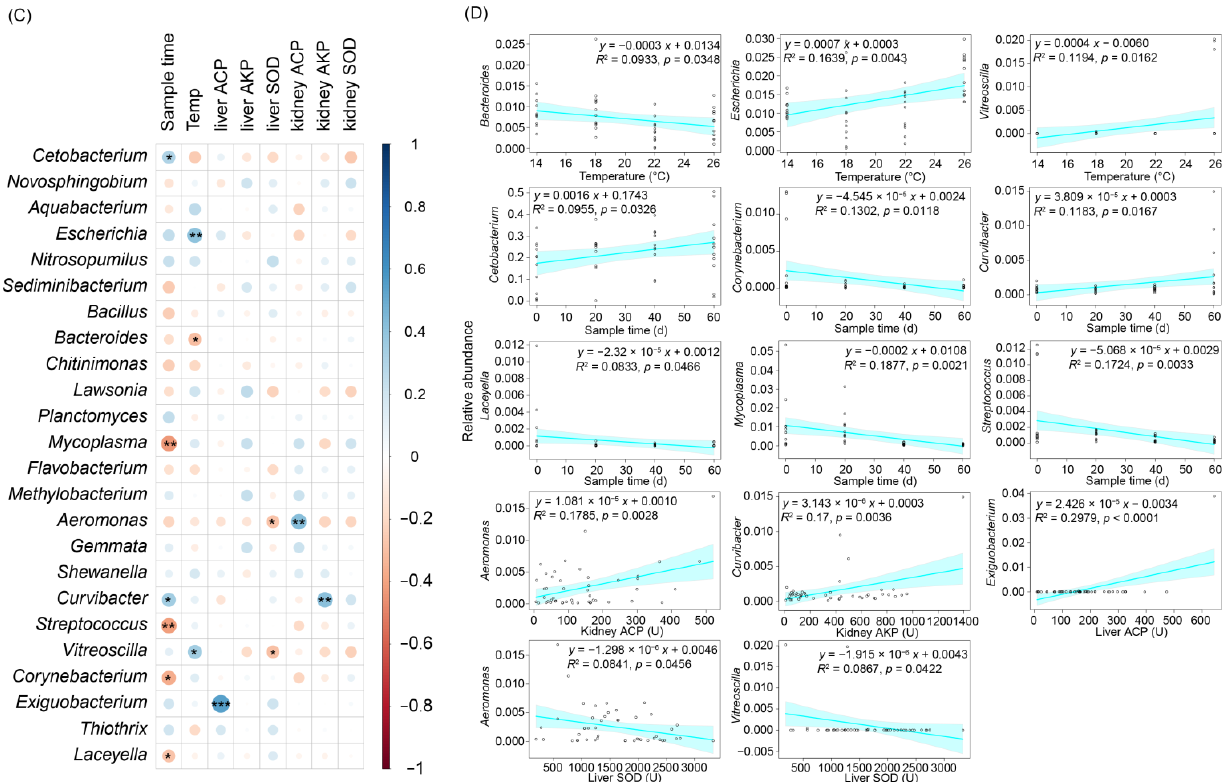
Figure 8. Correlation between gut microbiota compositions and activities of ACP, AKP, and SOD in the liver and kidney of Percocypris pingi : ( A ) RDA profile shows the correlation between operational taxonomic unit (out) compositions of P. pingi gut microbiota and internal- and external-physicochemical factors; ( B ) RDA profile shows the correlation between dominant genus compositions of P. pingi gut microbiota and internal- and external-physicochemical factors; ( C ) the bubble chart shows the correlation between the commonly dominant genera of P. pingi gut microbiota and internal- and external-physicochemical factors; and ( D ) significant correlation between the commonly dominant genera of P. pingi gut microbiota and internal- and external-physicochemical factors. * p < 0.05; ** p < 0.01; *** p < 0.001.